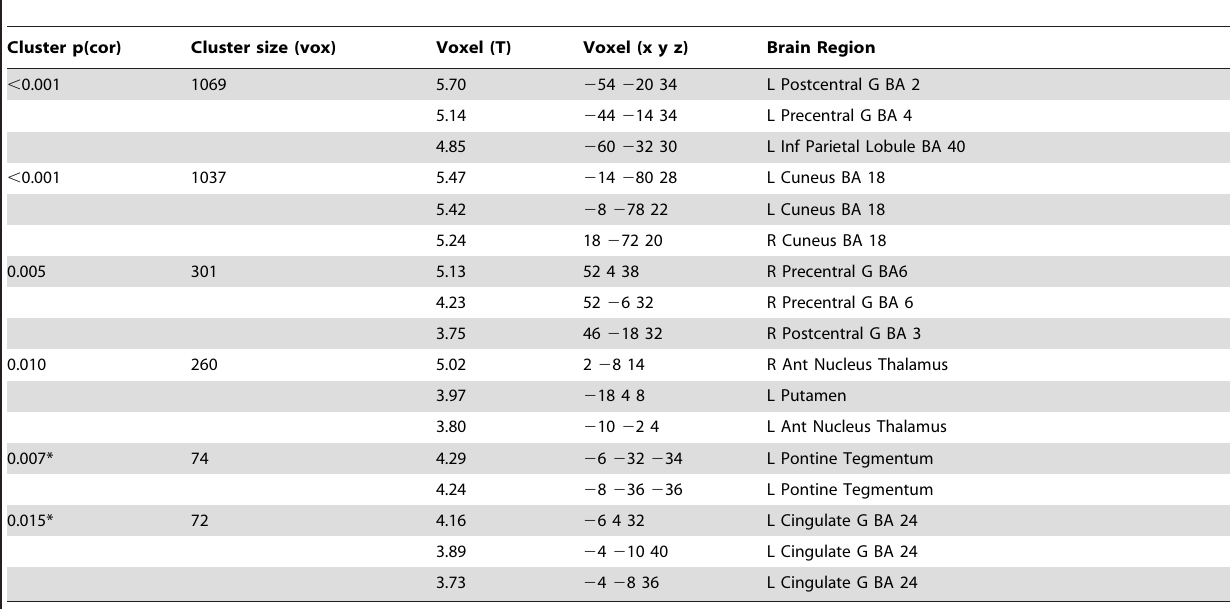
Cluster p(cor) Cluster size (vox) Voxel (T) Voxel (x y z) Brain Region , 0.001